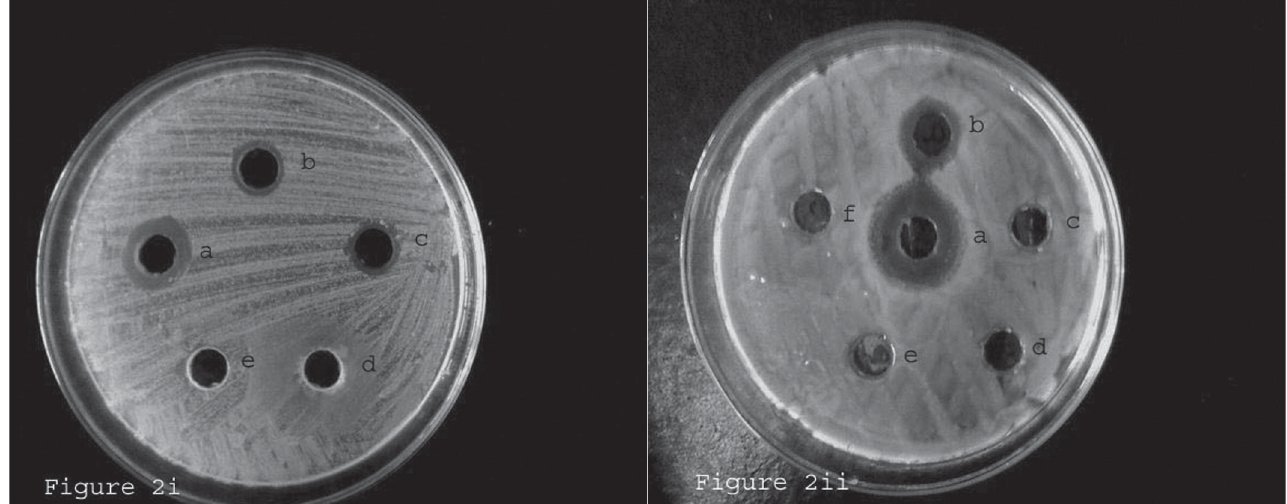
Fig. 2. MIC shown by acetonic extract of P. cubeba fruits against C. albicans (i) and S .aureus (ii) determined by modified agar well diffusion method using twofold serial dilutions of the extracts: 50 mg/mL (a), 25 mg/mL (b), 12.5 mg/mL (c), 6.25 mg/mL (d), 3.125 mg/mL (e) and 1.56 mg/mL